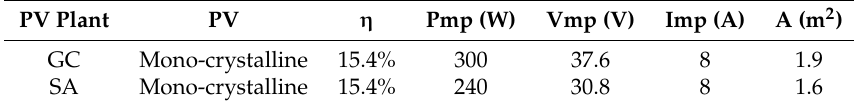
Table2. Photovoltaic(PV)panelfeaturesbytechnicaldatasheet. GC—grid-connected;SA—stand-alone. Table 2. Photovoltaic (PV) panel features by technical datasheet . GC—grid-connected; SA—stand- alone.